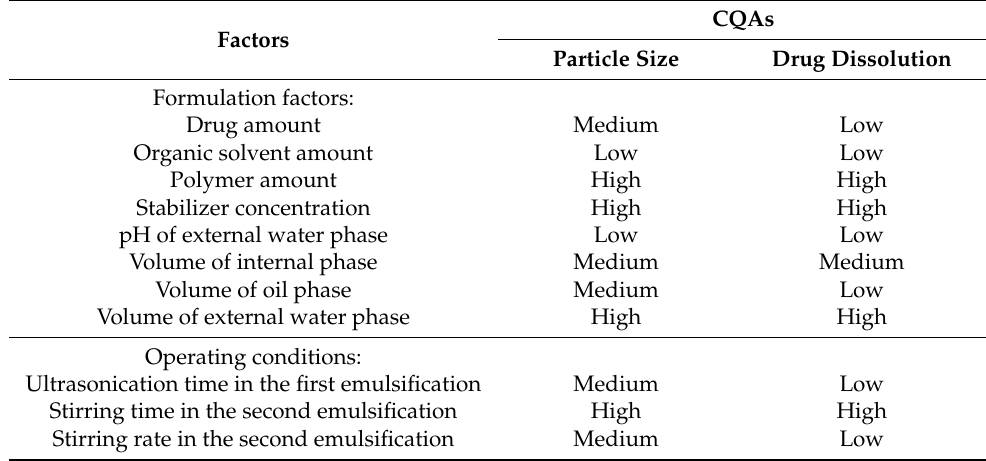
Table 2. Initial risk assessment for the formulation factors and operating conditions of microparticle preparation by DESE .